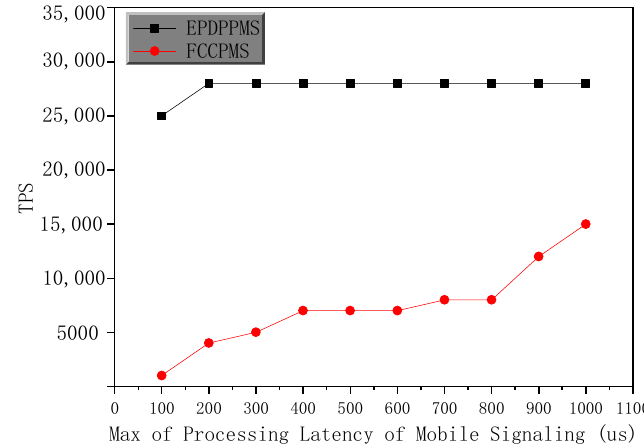
Figure 7. Ability of EPDPPMS and FCCPMS.